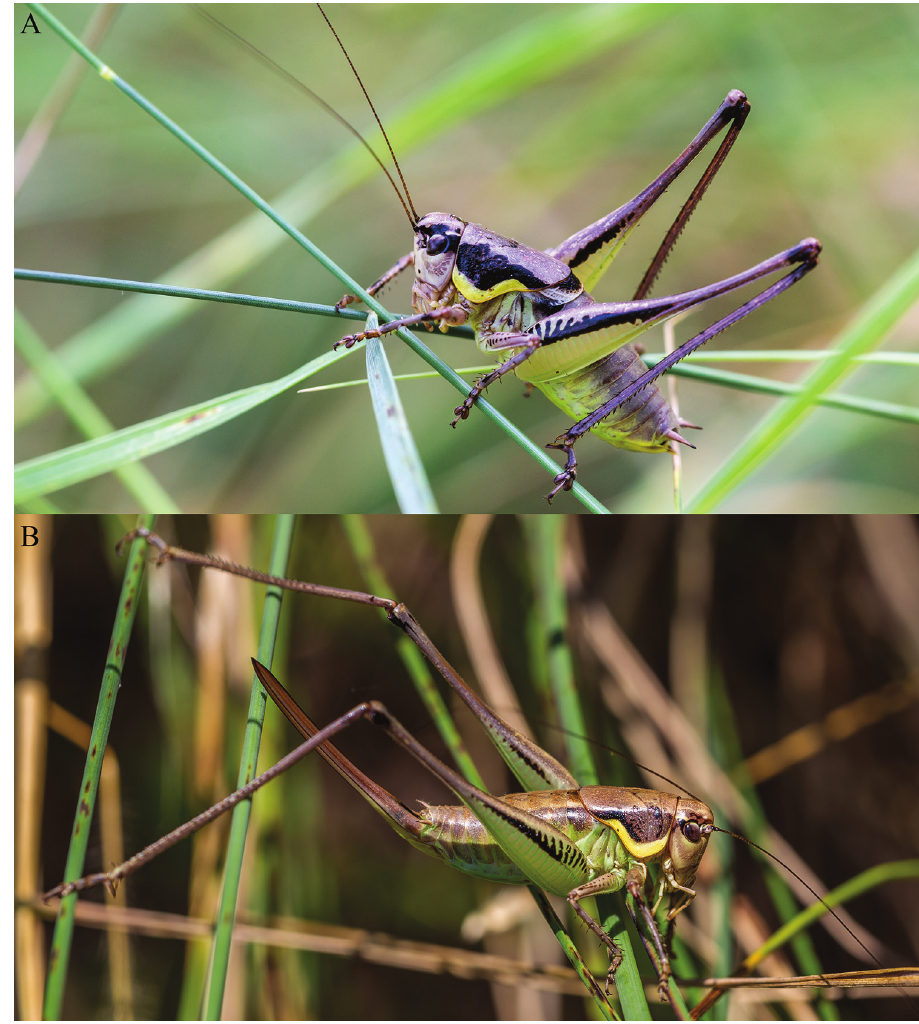
Figure 2. The habitus of Parapholidoptera castaneoviridis in the northernmost known location: A male B female (Romania, Ciucurova, 2016.07.03). Table 1. Descriptive statistics of male calling song parameters in Parapholidoptera castaneoviridis from south-eastern Romania (n = 100 measurements/male from 3 males). All values are given in